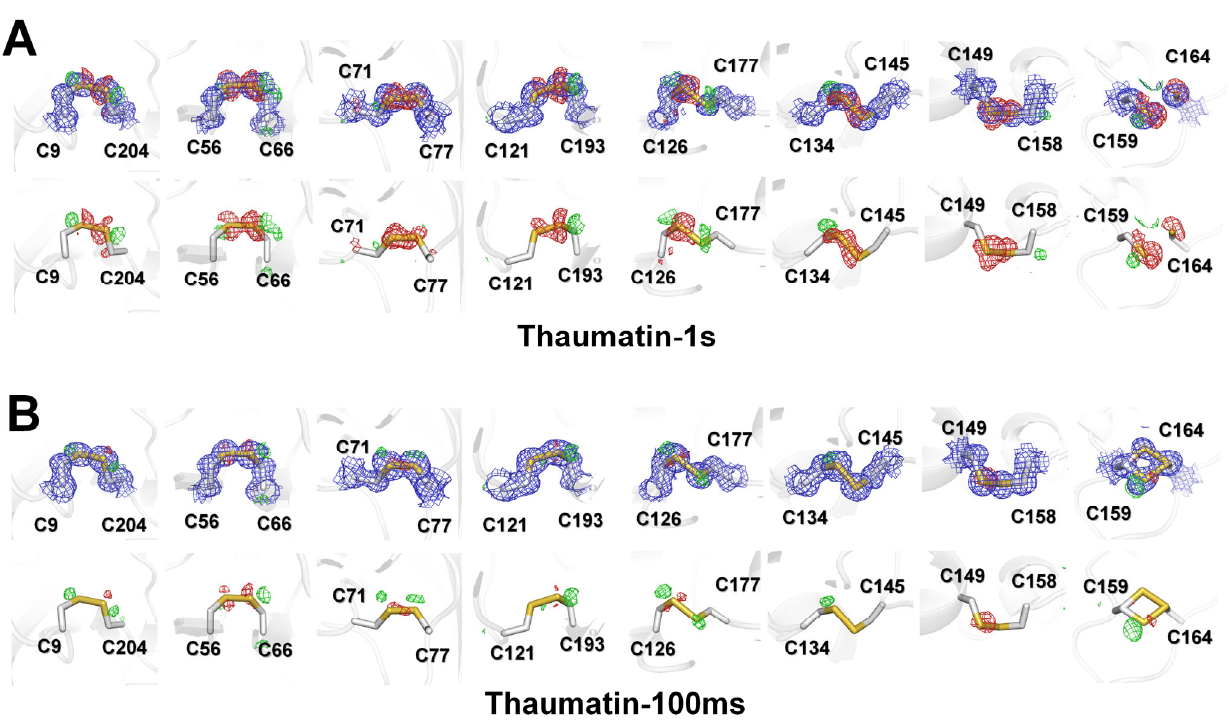
Figure 5. 2mFo ‐ DFc (blue mesh, 1 σ ) and mFo ‐ DFc (green mesh, 3 σ ; red mesh, − 3 σ ) electron density map of disulfide bonds in ( A ) Thaumatin 1s and ( B ) Thaumatin 100ms . (Upper) 2mFo ‐ DFc and mFo ‐ DFc; (lower) mFo ‐ DFc.